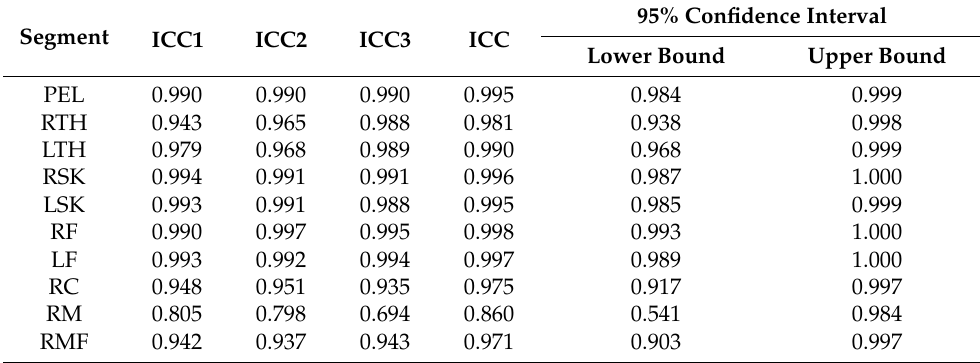
Table 5. Objectivity of lower limb segments length. Mean interclass correlation coefficient computed from three single standing calibration trials and from all records of each segment by eight evaluators.